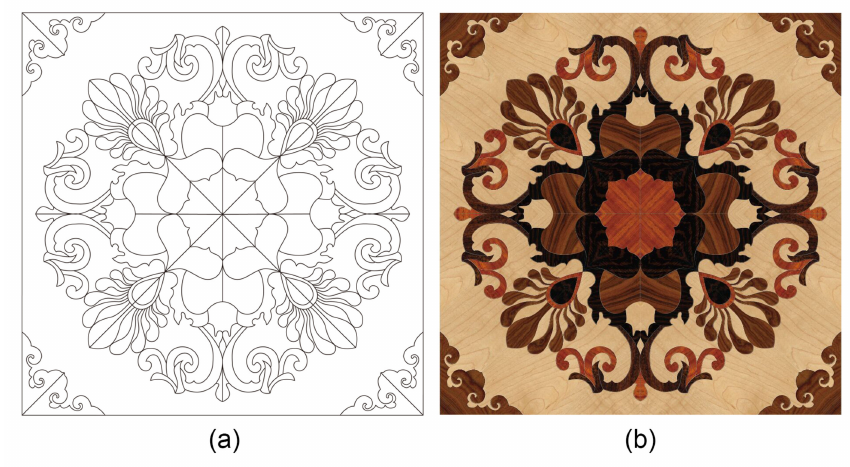
Figure 4. ( a ) Path design and ( b ) fill with color and